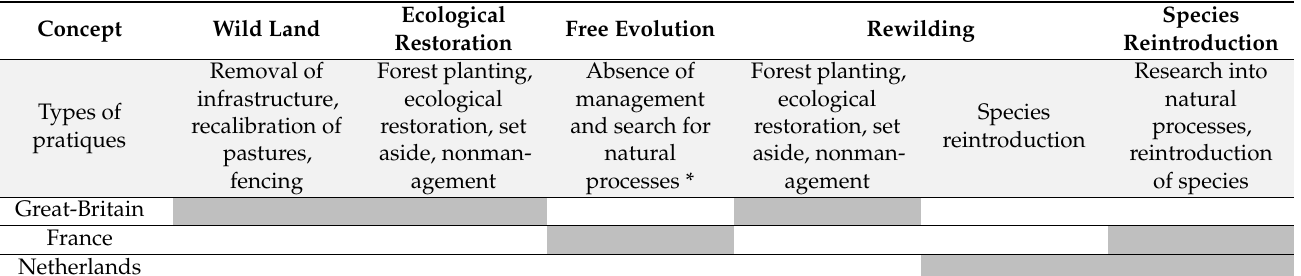
The shaded boxes correspond to the strategies mobilized by the stakeholders according